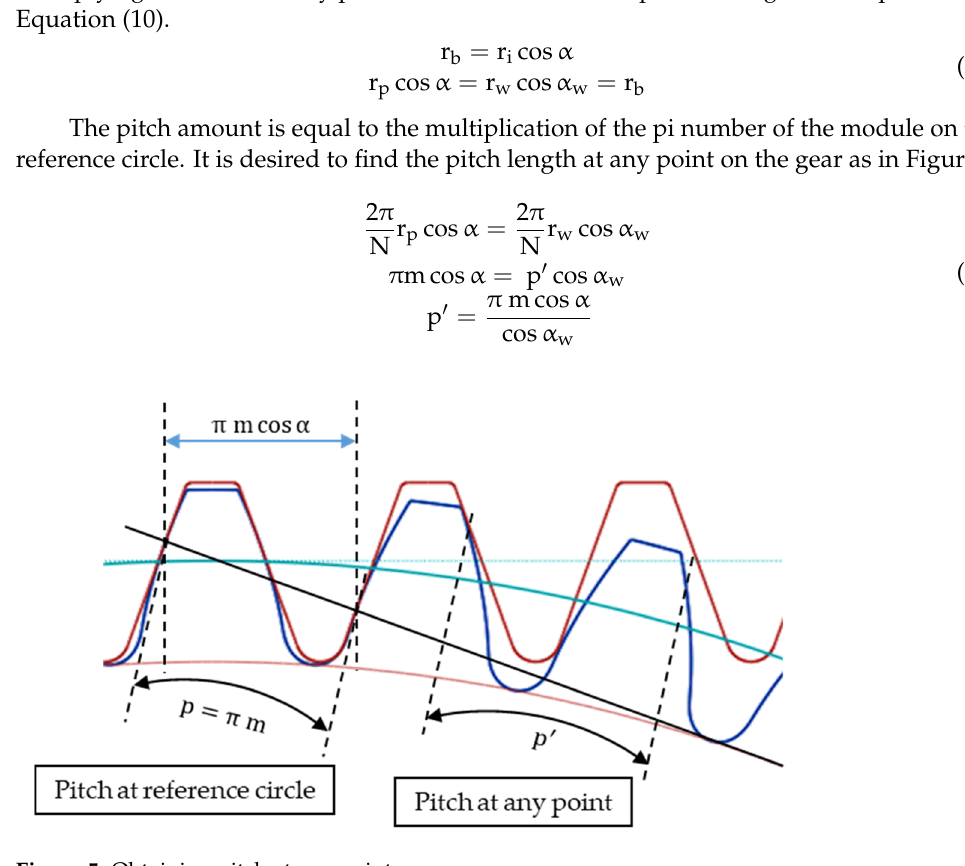
Figure 5. Obtaining pitch at any